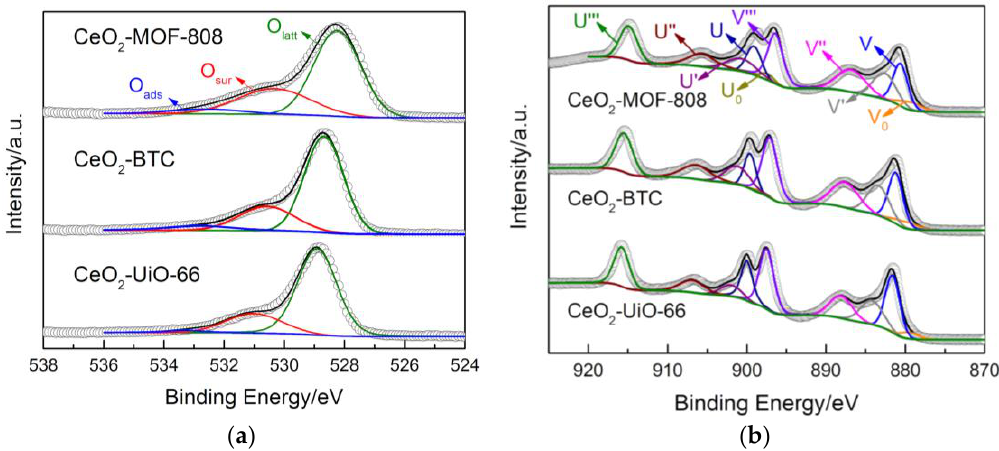
Figure 7. The surface ( a ) O1s and ( b ) Ce3d spectra of three CeO 2 -MOF samples.